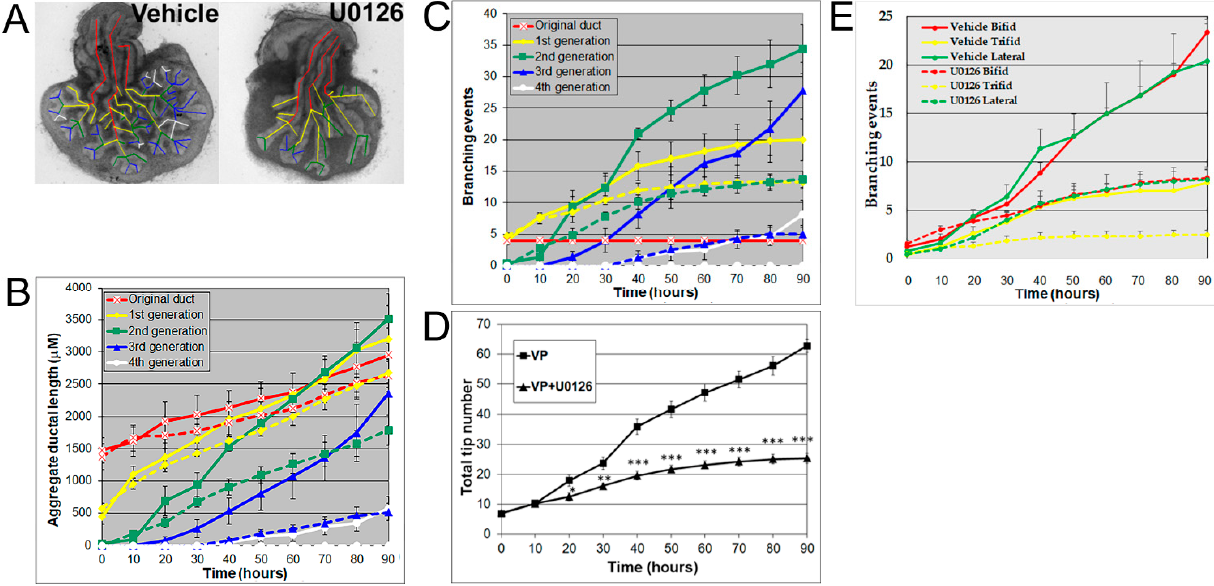
Figure 3. ( A ) Branch generation in contralateral rat pnd 0 VPs cultured for 90 h in the absence (left) or presence of 20 μ M U0126 (right). Successive images were taken every 30 min for 90 h to track branching events. A color-coded skeleton is used to indicate branch generation, as described in Figure 1. Representative end-point images at 90 h are shown. Note that untreated VPs formed branches up to the fourth generation, whereas U0126 treatment blocked the formation of branches at the third generation. ( B ) Kinetics of prostatic bud and duct elongation over successive branch generations in pnd 0 VPs cultured for 90 h in the absence (solid lines) or presence of 20 μ M U0126 (dashed lines). The aggregate length ( μ m) of all ductal segments in each successive branch generation over time is shown. ( C ) Total number of branch point events in each ductal generation as a function of time. Solid lines represent data from untreated VPs, and dashed lines represent data from U0126-treated VPs. Error bars denote SEM from 5–7 sets of experiments. Differences between the two groups were statistically significant ( p < 0.05) from 50 h onward, except for the original ducts. ( D ) Total tip number in 3D analysis as a function of time in rat contralateral pnd 0 untreated VPs (squares) and U0126-treated VPs (triangles) cultured for 90 h. Each data point represents the mean of 5–7 sets of experiments and bars denote SEM. * denotes significant differences between two groups, * p < 0.05, ** p < 0.01, *** p < 0.001. ( E ) Total counts of branching events occurring as terminal bifeds, terminal trifeds, or lateral side branches in VPs cultured in the absence or presence of 20 μ M U0126. Differences between the vehicles and U0126 treatments are statistically significant ( p < 0.05) from 50 h onward.